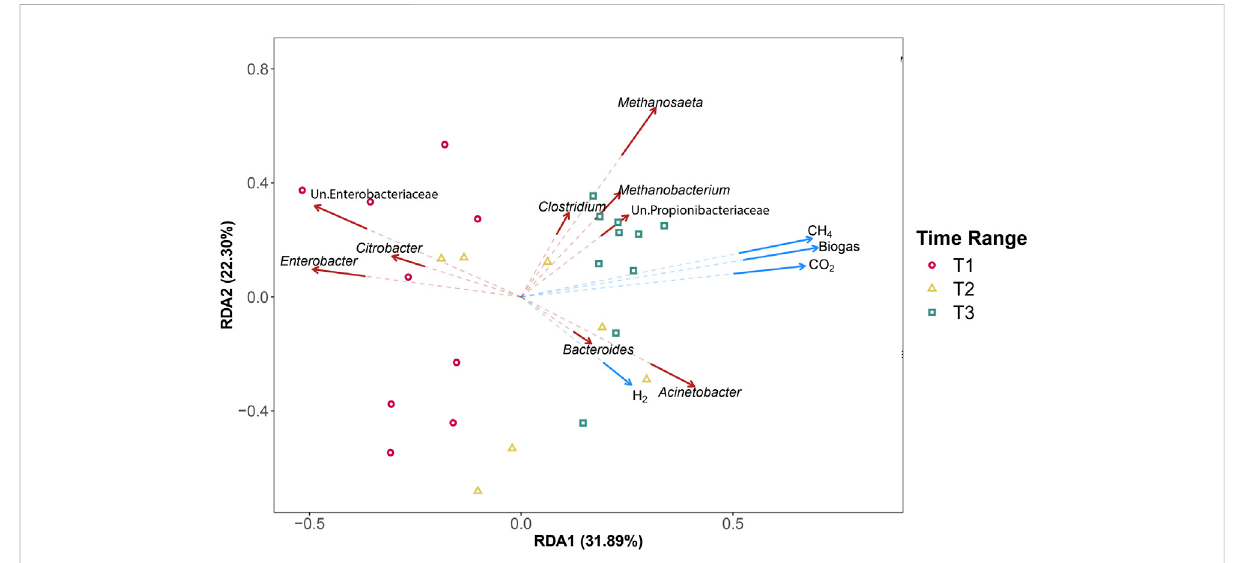
FIGURE 7 Redundancyanalysis(RDA)triplotshowingcorrelationsbetweentheproductionofbiogasconstituents(bluevectors)andselectedarchaealand bacterial families (red